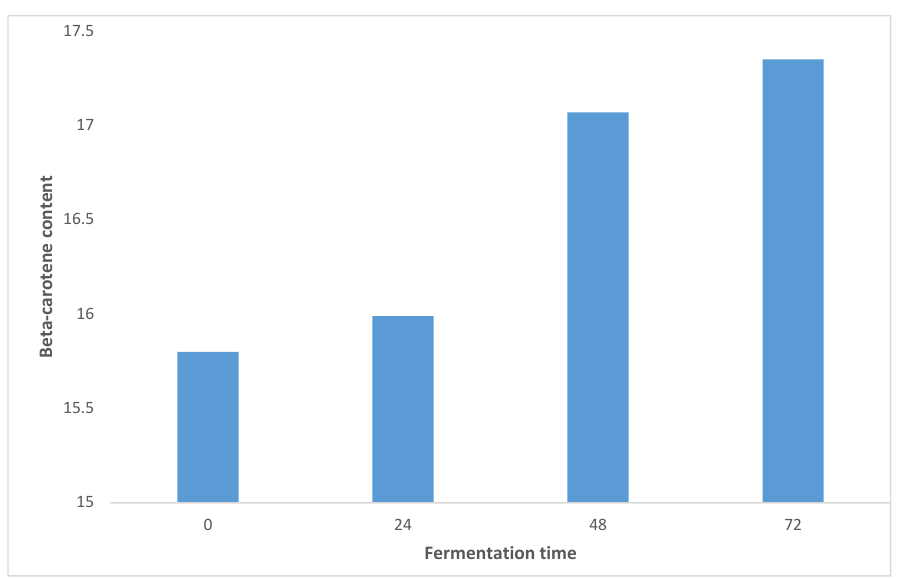
Figure 5. Effect of SSF on the retention of beta-carotene content of